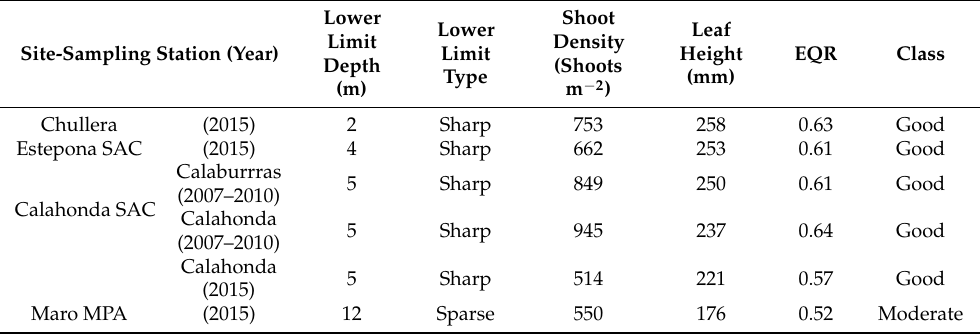
Table 5. Evaluation of the different Posidonia oceanica meadows studied in the northwestern Alboran Sea according to the BiPo index (Biotic Index Posidonia oceanica ) [55]. Ecological quality ratio (EQR) of the BiPo index is indicated, with values ranging between 1 (in reference condition) and 0 (in the worst condition) according to